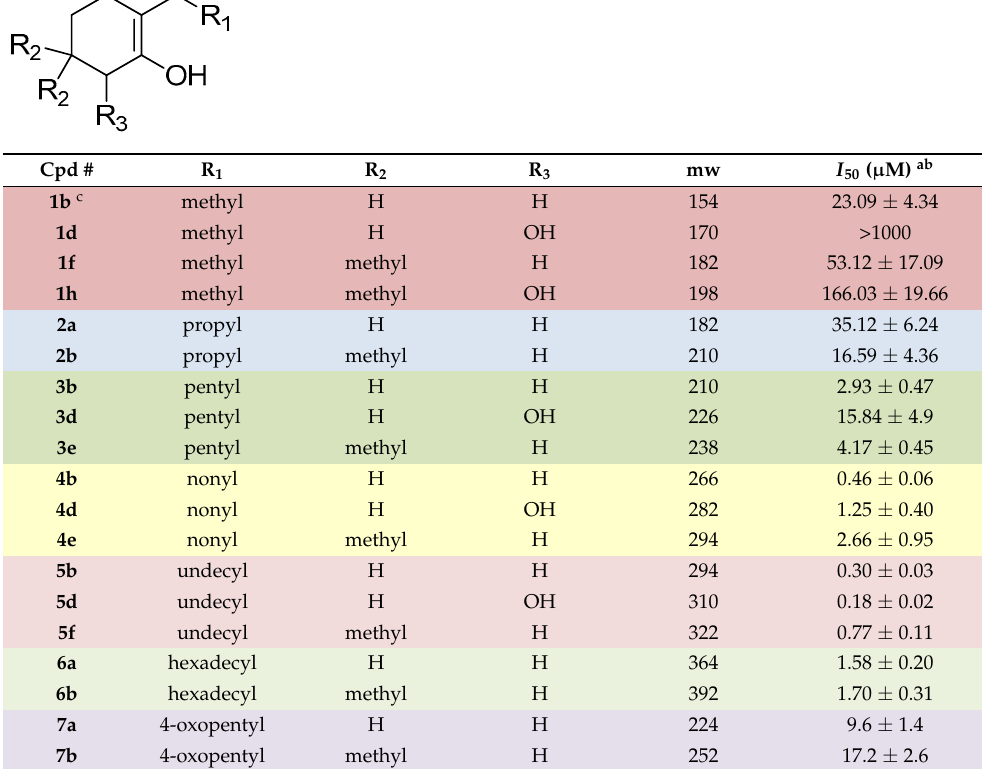
Figure 2. Titration of HPPD activity in TSP extract as measured by oxygen consumption in the pres- ence of 0 ( ) and 3.75 μ M of 4b ( ). The reaction mixture contained 0.2 M sodium phosphate buffer (pH 7.2), 1.8 mM ascorbate, 0.2 mM HPP, total soluble protein (0.3–0.5 mg) in a total volume of 3 mL and was incubated at 37 °C. Enzyme and inhibitor were incubated together for 3 min prior to the initiation of the enzymatic reaction by the addition of substrate. Table 1. Structures and activities of 19 2-acyl-cyclohexane-1,3-diones with simple aliphatic side chains tested in this study.